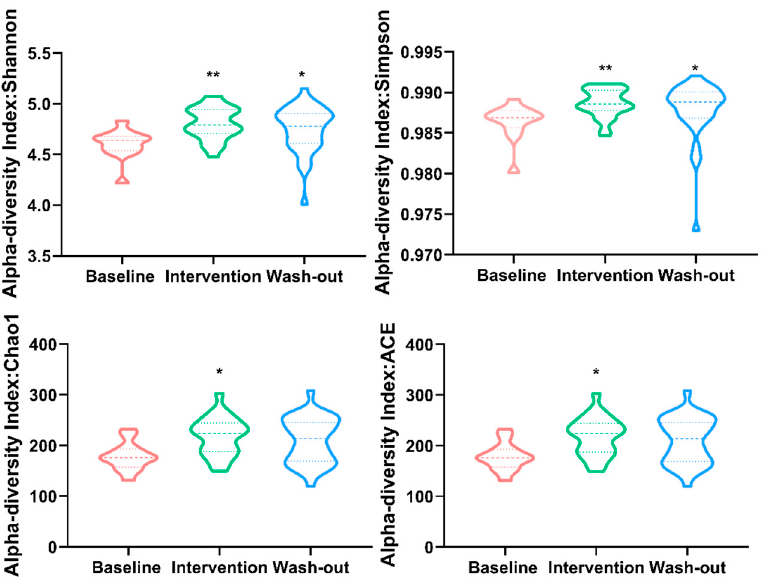
Figure 3. Alpha diversity measure using Chao1, ACE, Simpson, and Shannon at ASV level represented as violin plots. Each plot represents the diversity distribution of a group present (Data use nonparametric statistics Kolmogorov-Smirnov test for significant difference analysis, statistical significance: * p -value < 0.05, and ** p -value < 0.01 compared with baseline group).